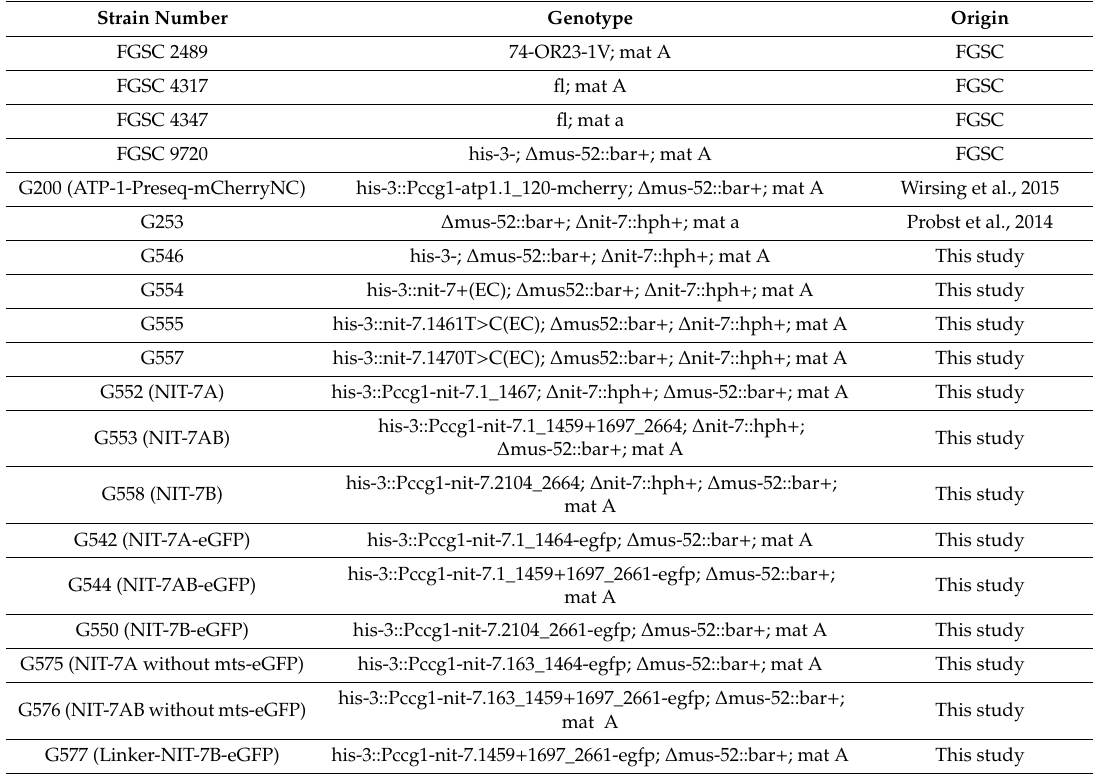
Table 1. Neurospora crassa strains used in this work. Next to the strain number, for P ccg-1 driven genes, the encoded protein product is given in parenthesis. mts: mitochondrial targeting sequence. eGFP: enhanced green fluorescent